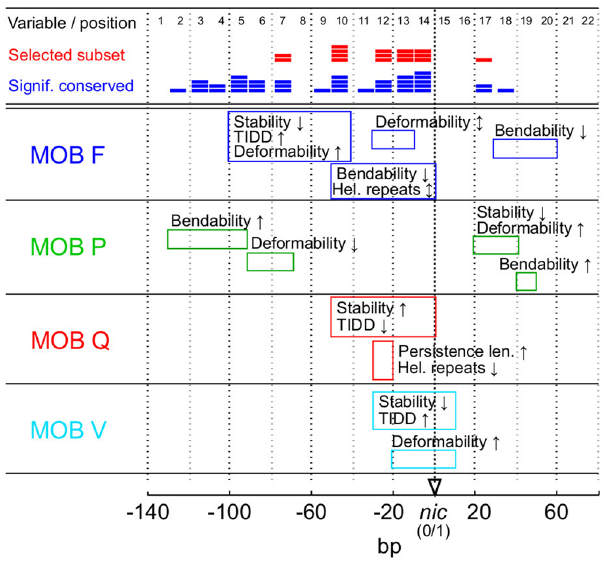
Figure 5. Overview of structural properties and variable analysis in oriT regions from four MOB groups. Shown are the most prominent structural properties that separated a particular MOB group from the other groups (see details in Supp. Fig. S5). Also depicted at specific positions are the amount of variables from the selected subset (Fig. 4, red color) and the amount of variables with significant conservation (Fig. 3, blue